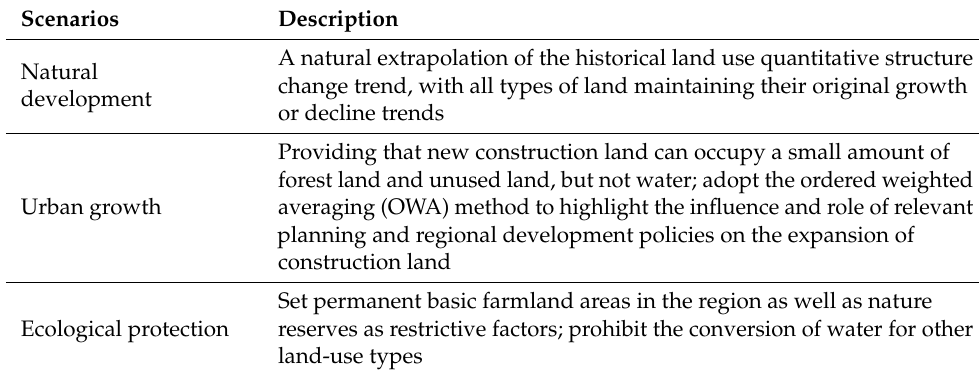
Table 1. Details of three different scenarios tested in the framework for delineation of the urban growth boundary